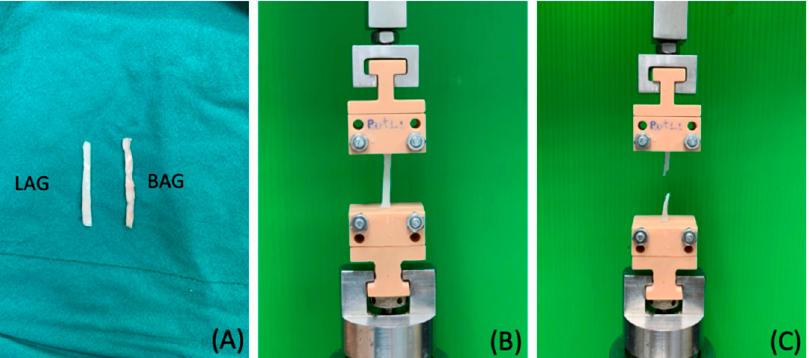
Figure 3. ( A ) Dissected buccal and lingual porcine attached gingiva; ( B ) experimental setup of the